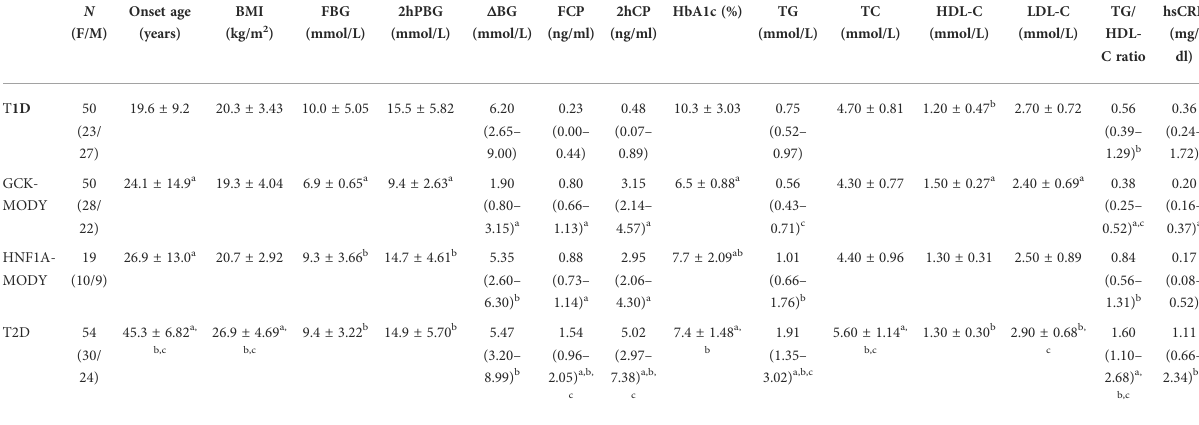
TABLE 1 General characteristics of each